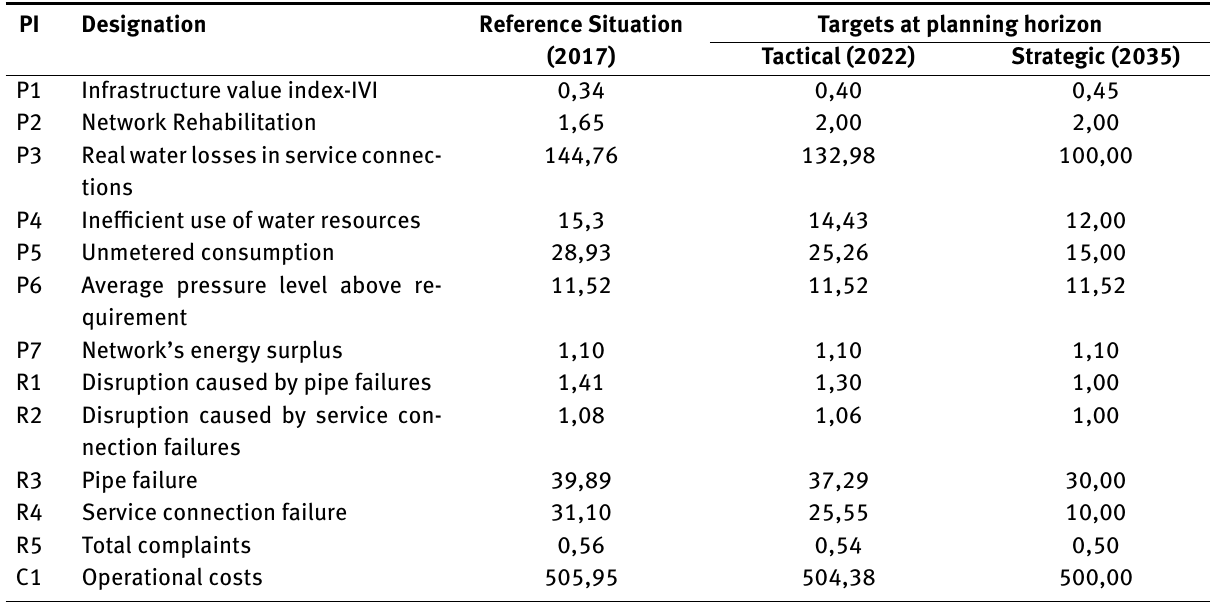
Table 1: Obtained results for the reference situation and targets establishment